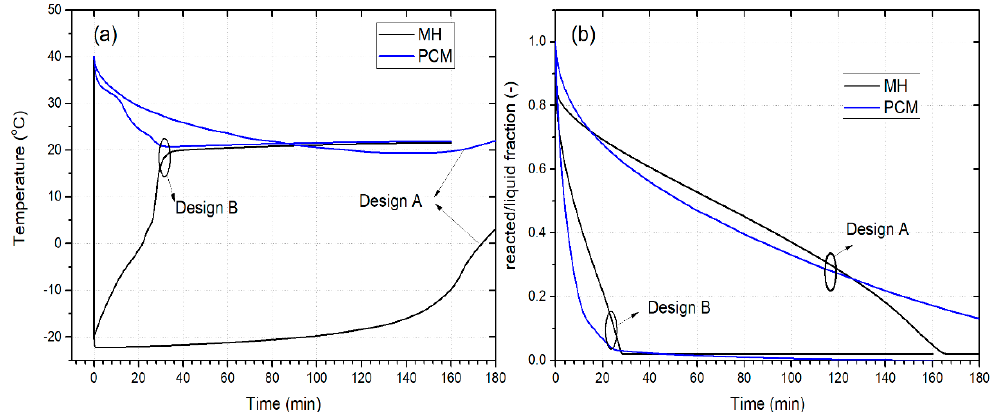
Figure 2. Comparison of dehydrogenation dynamics between the designs A and B. ( a ) average temperature; ( b ) reacted and PCM liquid fraction.